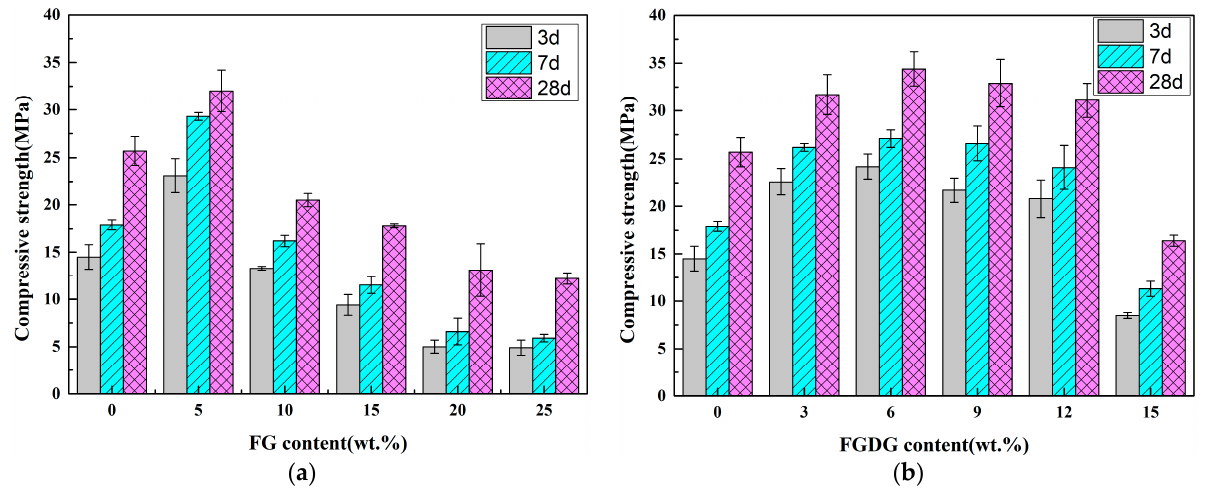
Figure 4. Compressive strength results with different gypsum content: ( a ) FG; ( b ) FGDG.